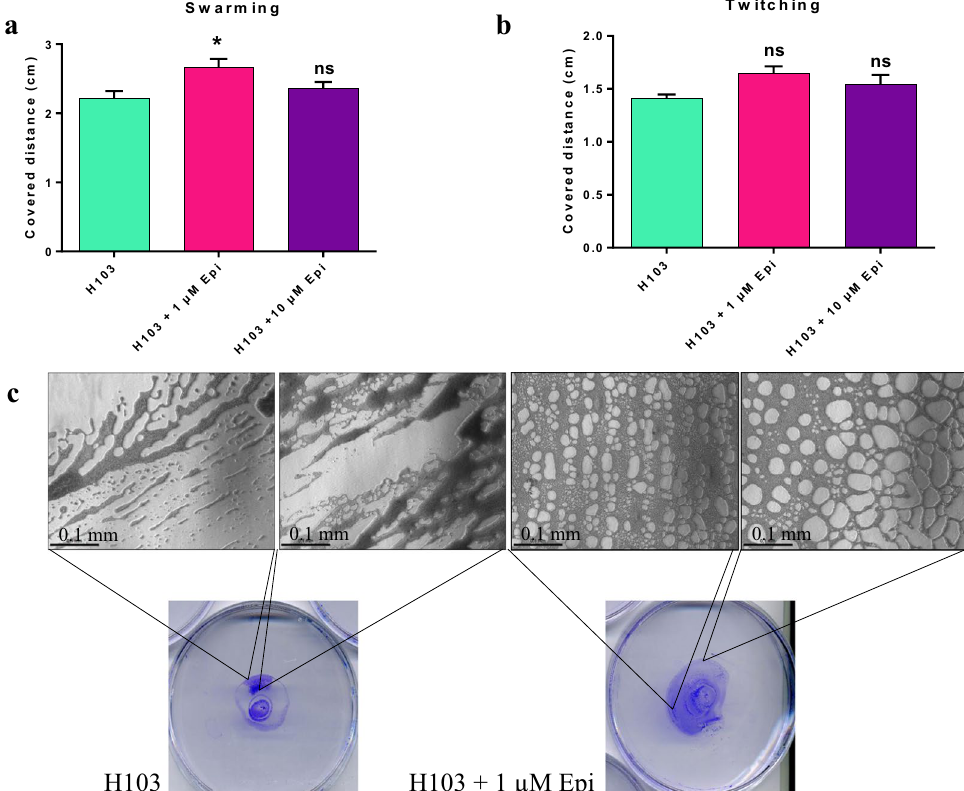
Figure 1. Effect of Epi on P. aeruginosa H103 motility. ( a ) Covered distance by swarming motility on LB 0.6% agar, after 24 h, ( b ) Covered distance by twitching motility on LB 1% agar, ( c ) Macroscopic and microscopic observations of twitching. Micrographs were taken with an Axio Vert A.1 inverted microscope, scale bar: 0.1 mm. The error bars indicate the standard error of the mean (SEM). Two-tailed paired t -test was used, (n = 6 and n = 3 for swarming and twitching assays respectively), * p = 0.0125, ns: not